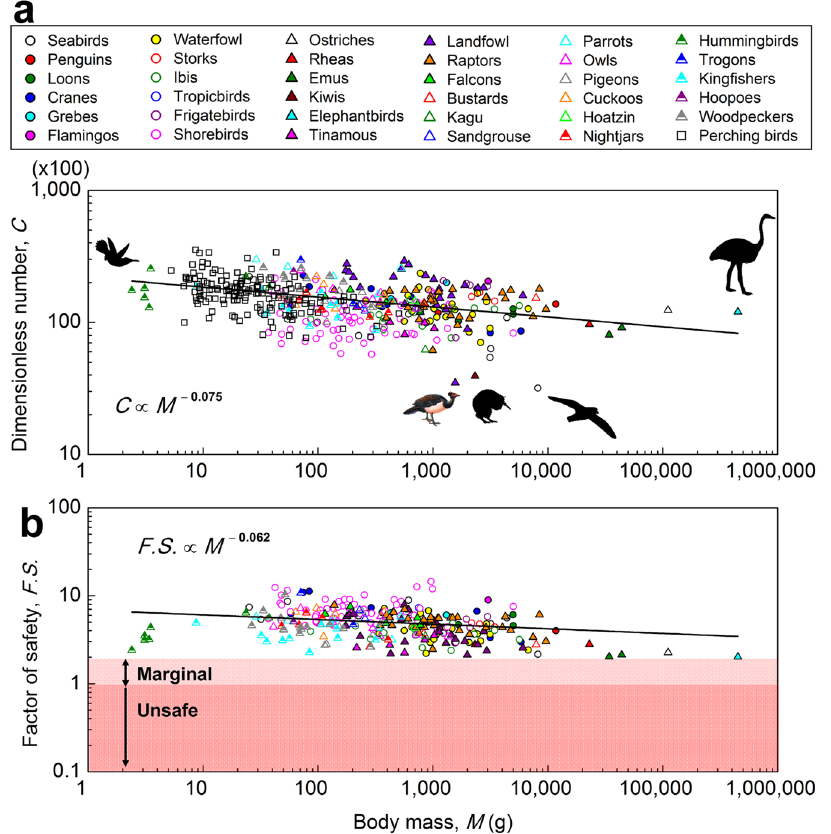
Figure 3. The C number and factor of safety based on published egg images and data (Method 2). ( a ) The C number of 430 species (36 orders, 104 families) predicted by the FEM simulations. The three species whose C depart substantially from the trend are maleos ( Macrocephalon maleo ), southern brown kiwi ( Apteryx australis ), and wandering albatross ( Diomedea exulans ). Their F.S ., however, align well with other species. ( b ) Factor of safety, showing three regions: safe ( F.S . > 2), marginal (1 < F.S . < 2), and unsafe ( F.S . < 1). Each point